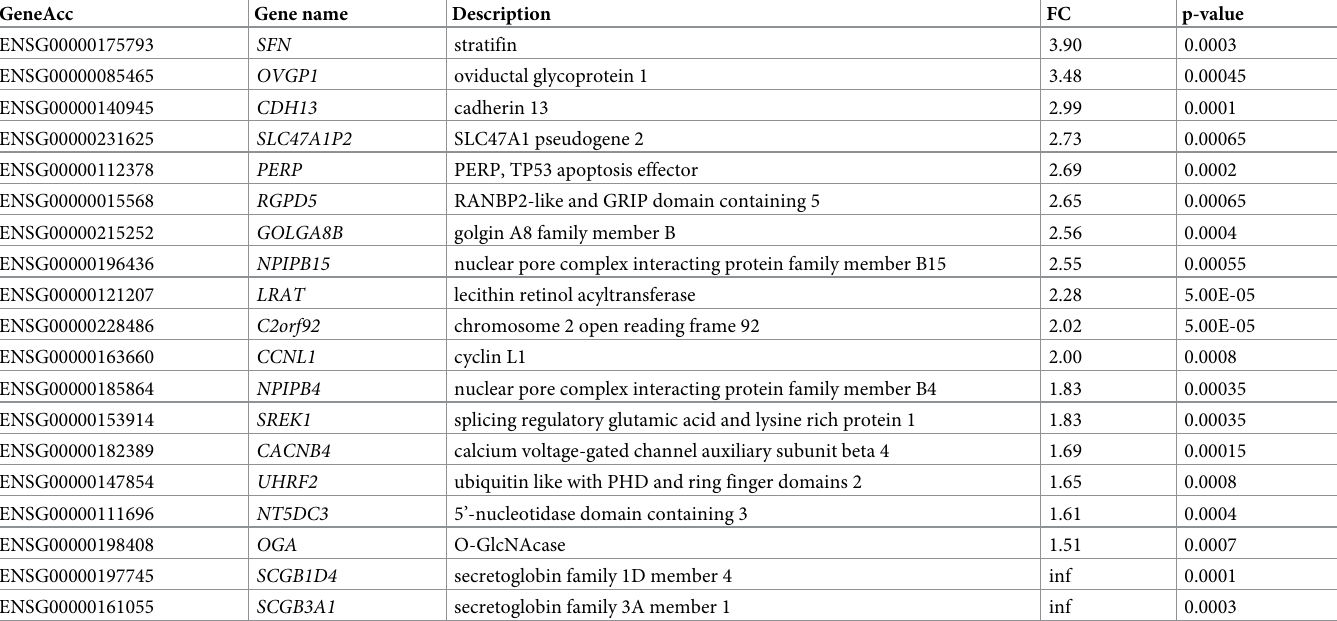
Table 2. Top 20 up-regulated genes in the poor-quality embryo transfer group compared with the good-quality embryo transfer